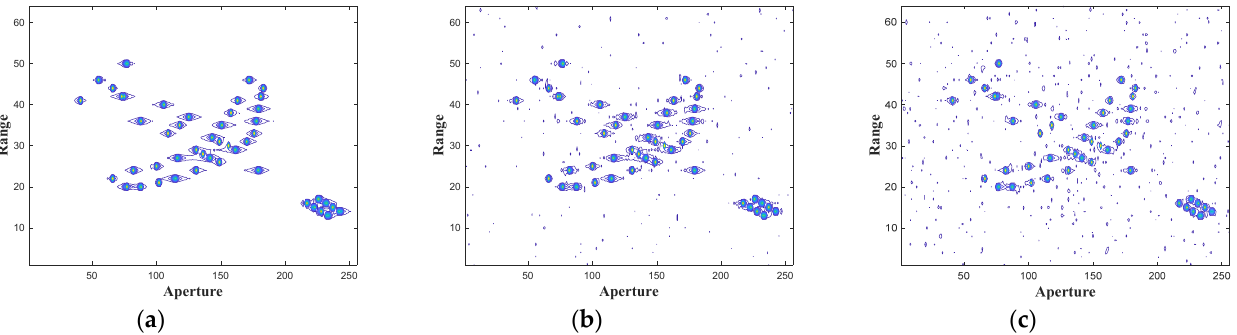
Figure 8. The recovered image applied the KF ‐ tracking method under different SNR levels. ( a ) 20 dB. ( b ) 10 dB. ( c ) 5 dB.